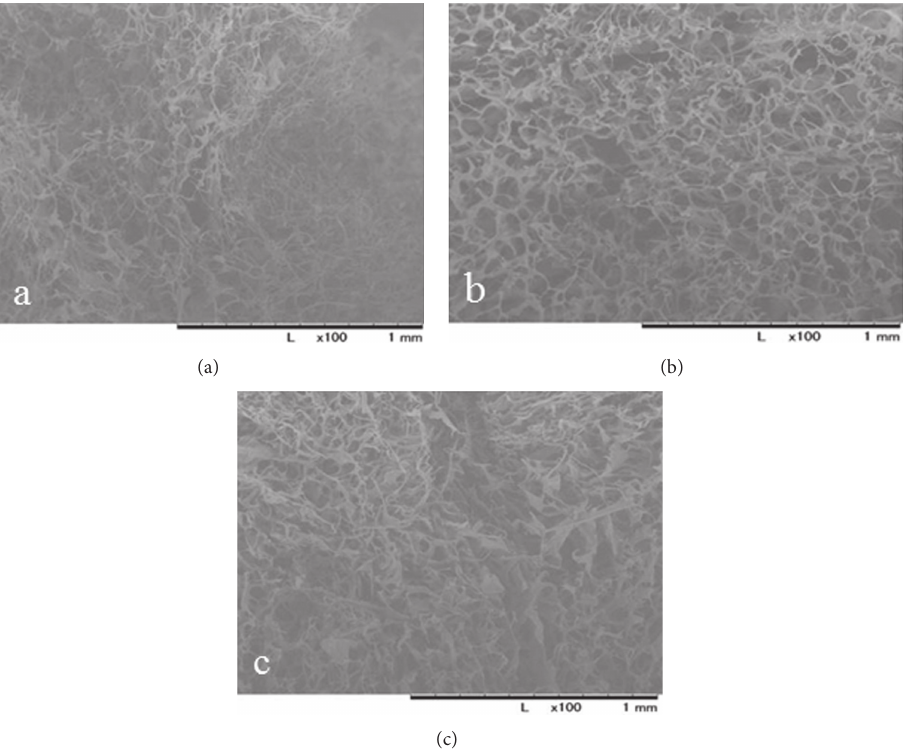
Figure 3: The surface images of sponges produced from different concentrations of TAC solution: (a) 0.5% (v/v), (b) 1.0% (v/v), and (c) 2.0% (v/v).